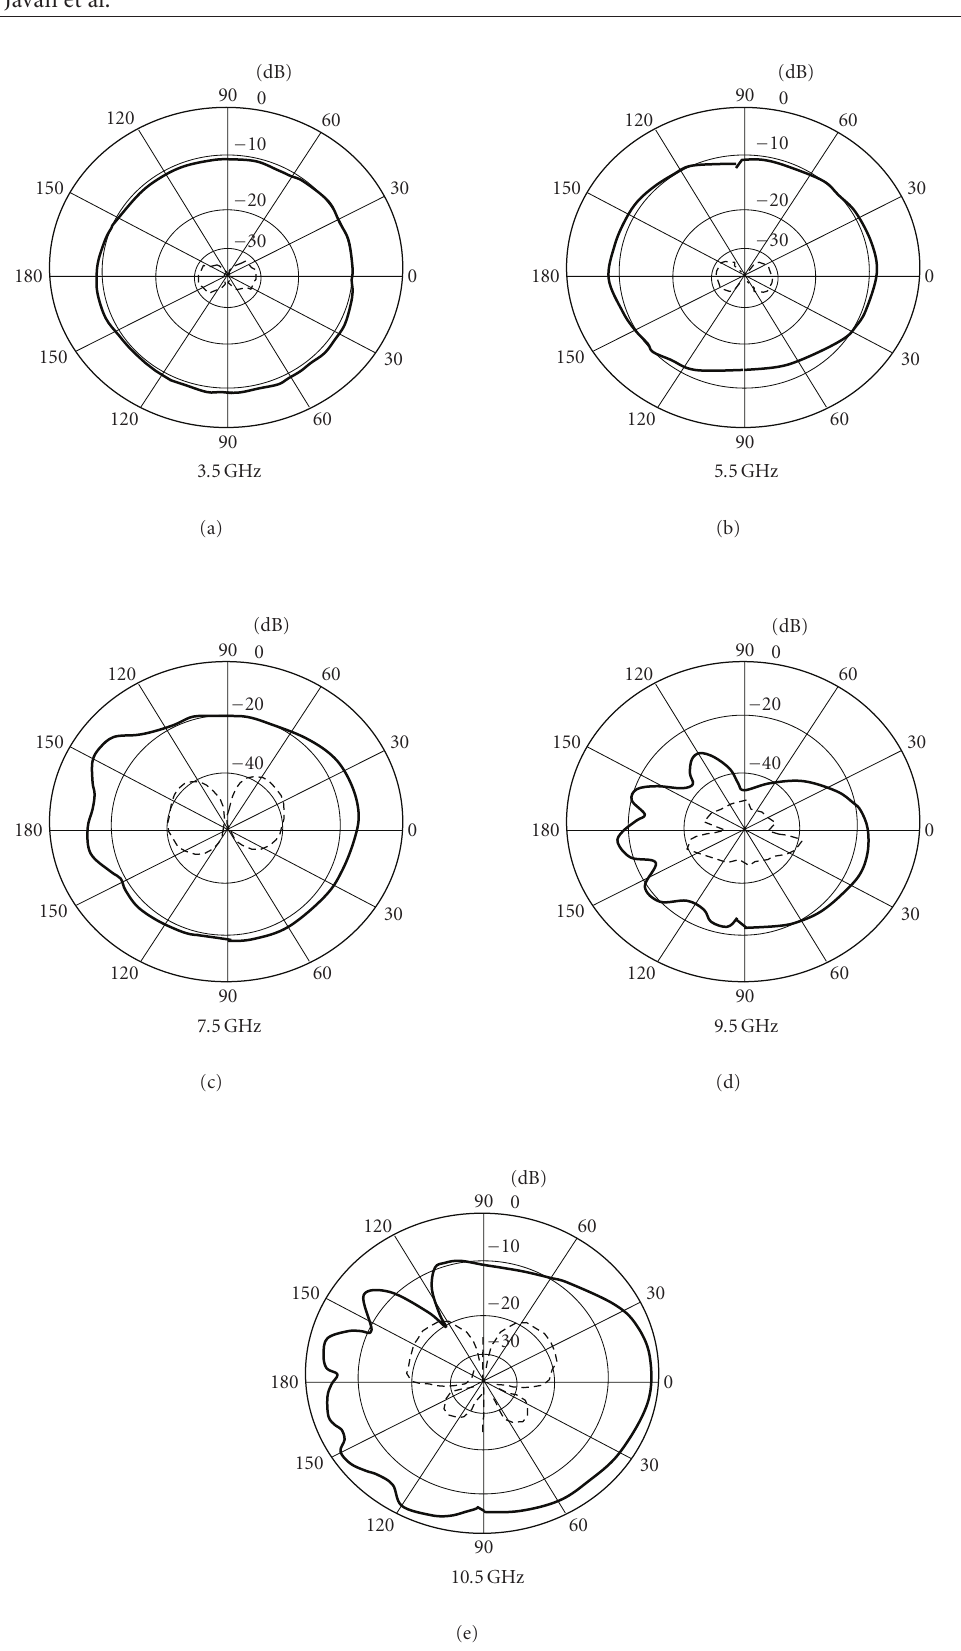
Figure 9: Measured radiation pattern of cross-slot antenna in E-plane ( ϕ = 90 ◦ ). The solid line is copolar and the dash line is cross-polar